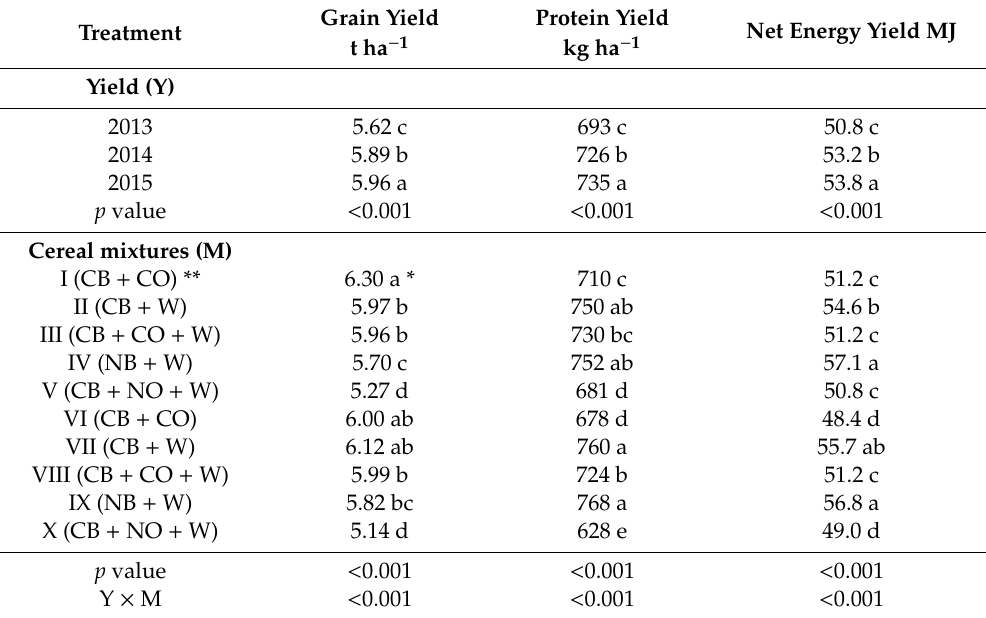
Table 6. Yields of various spring cereal mixtures on Albic Luvisols.